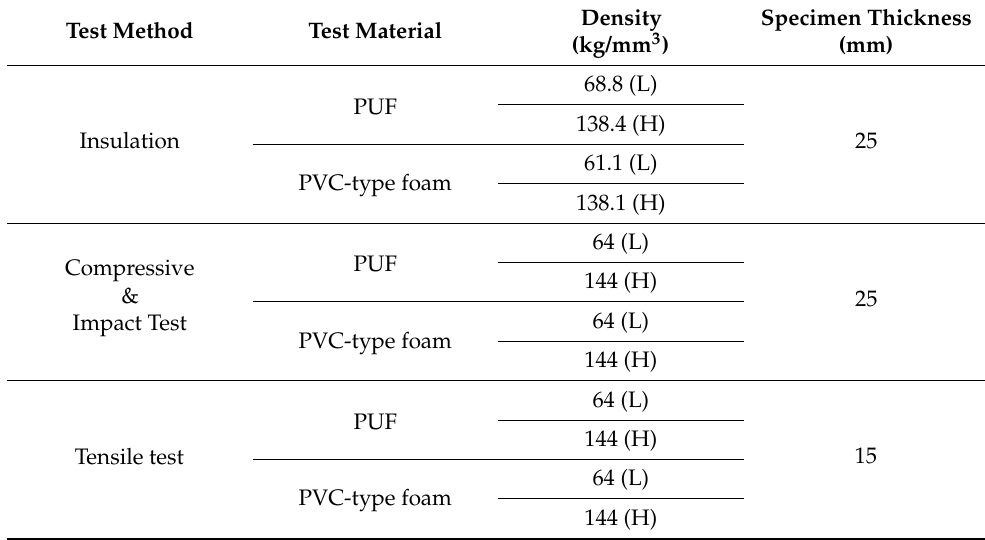
Table 1. Average density of the PUF and PVC-type foam for each